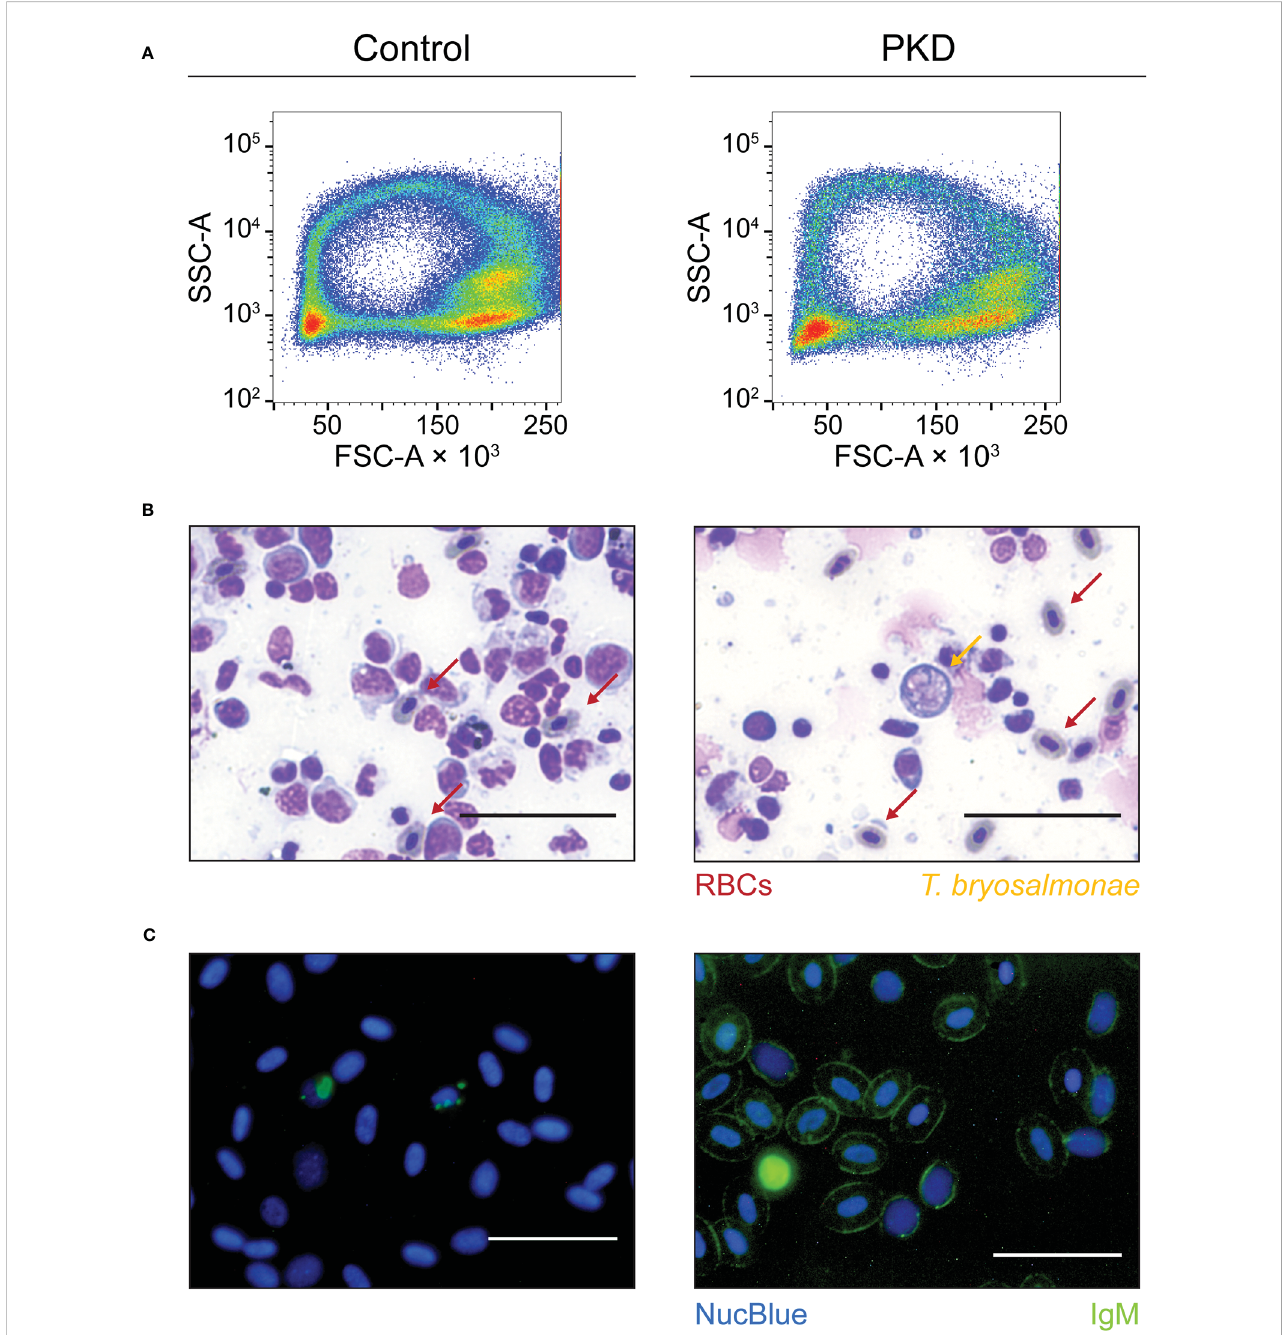
FIGURE 2 The red blood cells (RBCs) from control fi sh and infected fi sh are comparable in morphology and complexity. The labels at the top of the fi gure apply to the whole fi gure, not only to Figure 2A. They indicate that images or plots shown on the left column originate from control fi sh and that those from the right column originate from infected fi sh (PKD). (A) As an initial population level study of the size and density/granularity of the RBC population (every cell of a population represented by one event or “ dot ” ), we pro fi led the forward scatter (FSC) and side scatter (SSC) respectively of RBCs from control and infected fi sh (PKD). The RBC population of both groups are comparable and representative of measurements taken from all fi sh studied. Cell clusters are apparent from the colors red and yellow indicating higher density of events or cells at those locations. The RBCs shown from the individual with PKD are over 95% IgM + as determined by fl ow cytometry. (B) An eosin-methylene blue stain also reveals the identical morphology of RBCs from the two groups (indicated by red arrows) alongside extrasporogonic T. bryosalmonae indicated by an orange arrow. These stains are from anterior kidney imprints in which IgM + RBCs are also abundant (Supplementary Figure 2). Furthermore, (C) we independently veri fi ed the surface IgM phenomenon on RBCs from control fi sh and fi sh with PKD by fl uorescence microscopy of whole blood stained with mAb 1.14 (green) and the NucBlue Live ReadyProbes Reagent (blue) that also reveals the regular morphology of IgM + RBCs. All scale bars represent 50 m